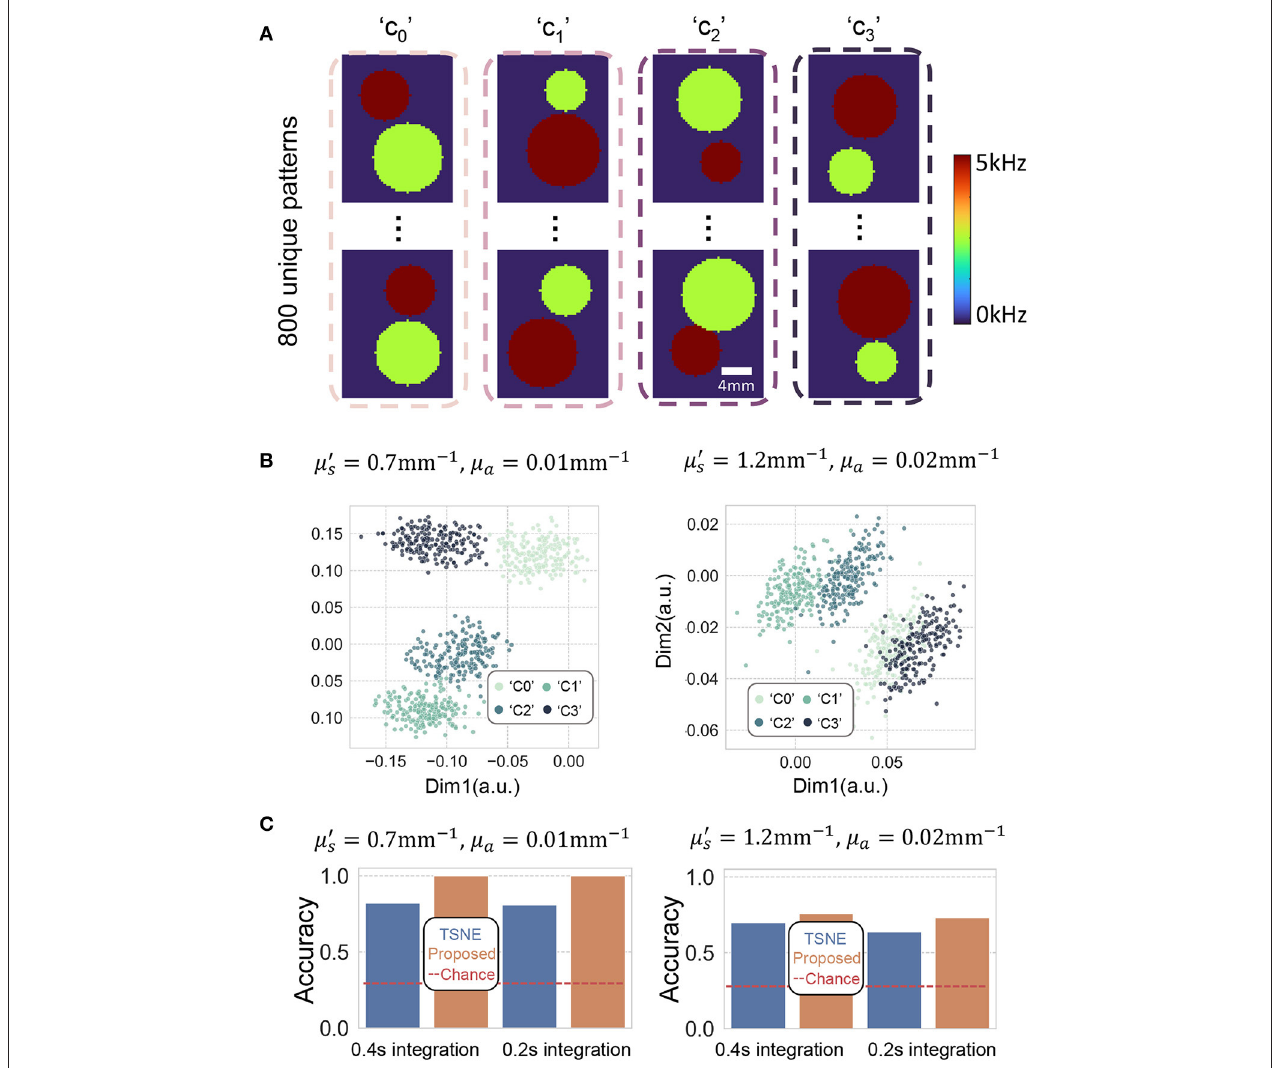
FIGURE 6 | (A) Depicts some representative spatio-temporally differing circular-shaped decorrelation events we attempted to classify. The perturbed decorrelations were generated by flipping the DMD at 5–10 kHz. (B) Plots two of the eight dimensions of the embedding using proposed method. The autocorrelations were computed using 0.4 s integration time. (C) Barplots of the classification accuracy of TSNE and proposed method using 0.2 and 0.4 s integration times. The red dashed line plots the baseline of chance, which is 0.25 for a quaternary classification